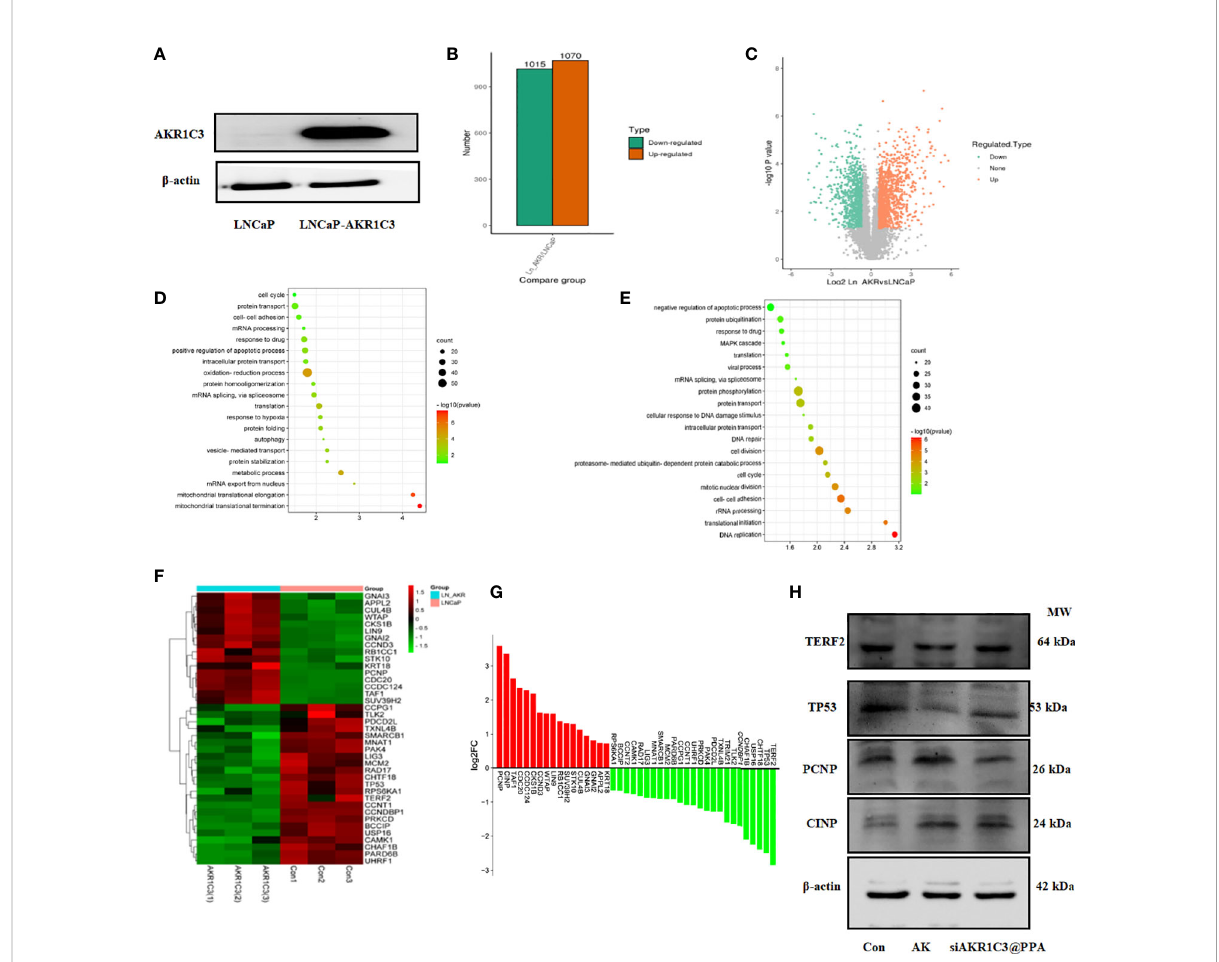
FIGURE 7 AKR1C3 induces the expression of cycle-related proteins. (A) Protein expression of AKR1C3 in LNCaP and LNCaP-AKR1C3 cells. (B) Volcano plot of differentially expressed proteins. Orange indicates high relative expression, and green indicates low relative expression. (C) Statistical map of differentially expressed proteins. Orange indicates high relative expression, and green indicates low relative expression. (D) Biological process (BP) enrichment analysis of upregulated proteins between LNCaP-AKR1C3 cells and LNCaP-vector cells. (E) Biological process (BP) enrichment analysis of downregulated proteins in LNCaP- AKR1C3 cells compared with LNCaP cells. (F) Heatmap comparing the expression of cell cycle proteins in LNCaP-AKR1C3 cells with that in LNCaP cells. (G) The relative fold changes in cycle-related protein levels; values are log2 converted means of relative fold-changes. (H) TERF2, TP53, PCNP, and CINP expression was veri fi ed by using Western